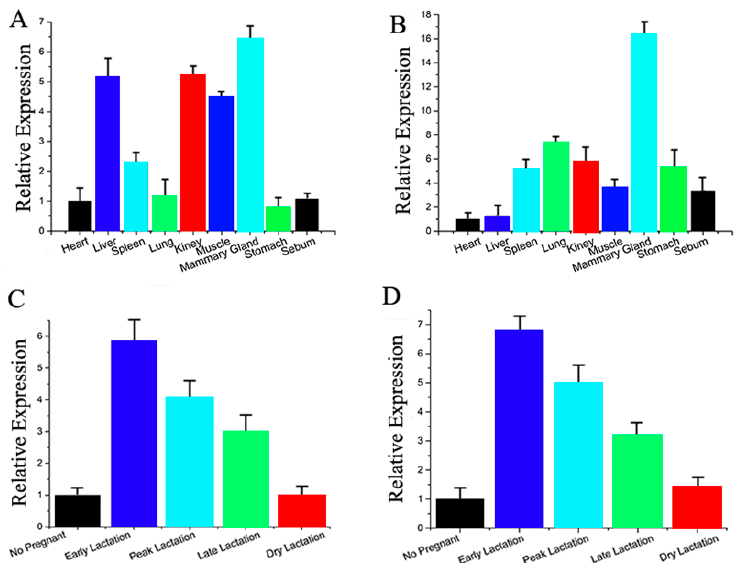
Figure 2. ( A ) miR-30e-5p expression in various tissues of dairy goats; ( B ) miR-15a expression in various tissues of dairy goats; ( C ) miR-30e-5p expression in various tissues of dairy goats; ( D ) miR-15a expression in various tissues of dairy goats. All experiments were duplicated and repeated three times. Values are presented as means ± standard errors